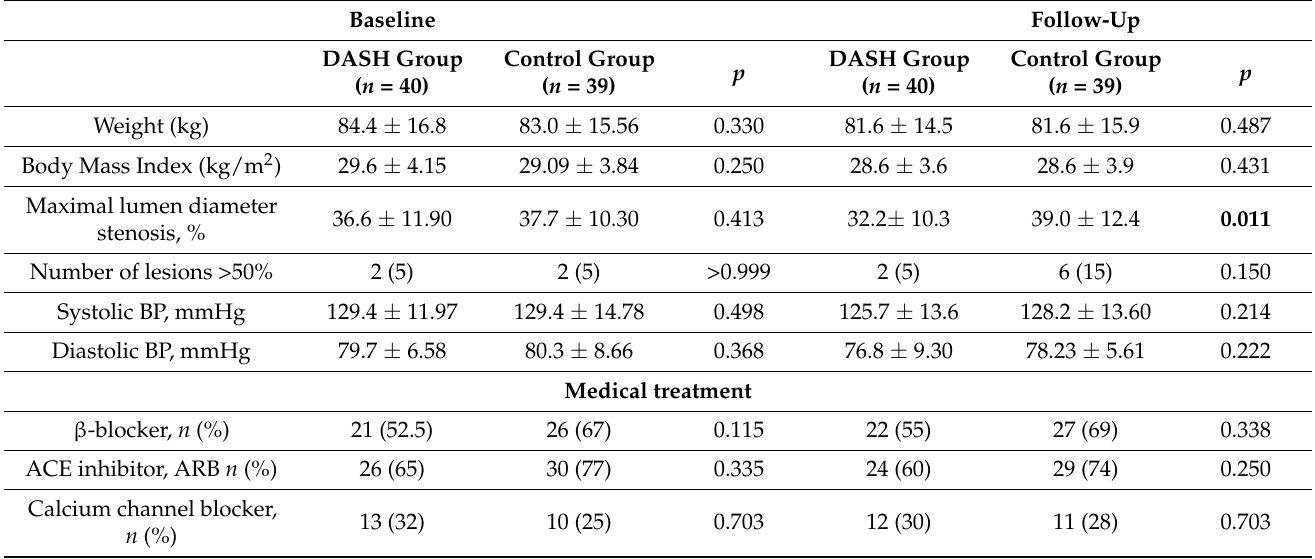
Table 2. Clinical parameters and concomitant medications at baseline and follow-up. Statistically significant p -values were marked in